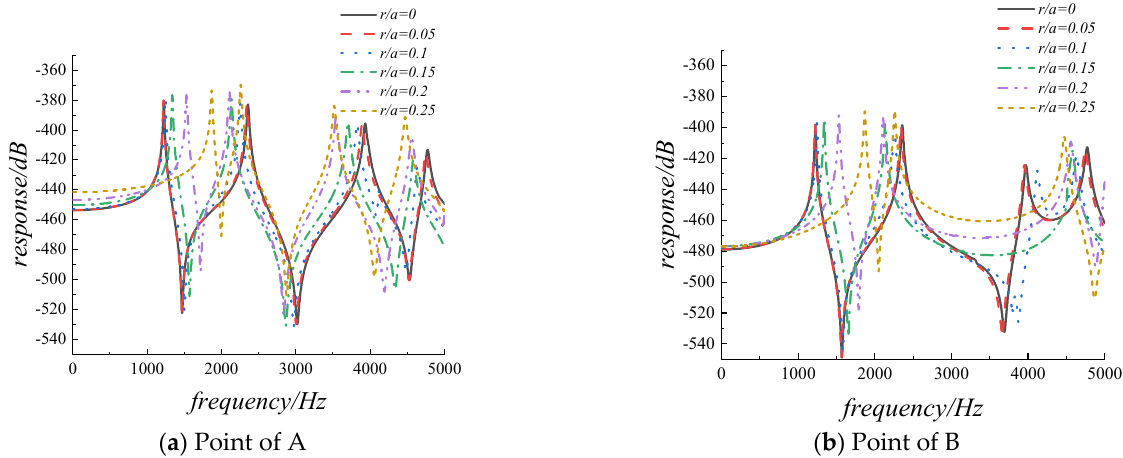
Figure 9. The displacement response for FGMs square plate with diverse cutout sizes.